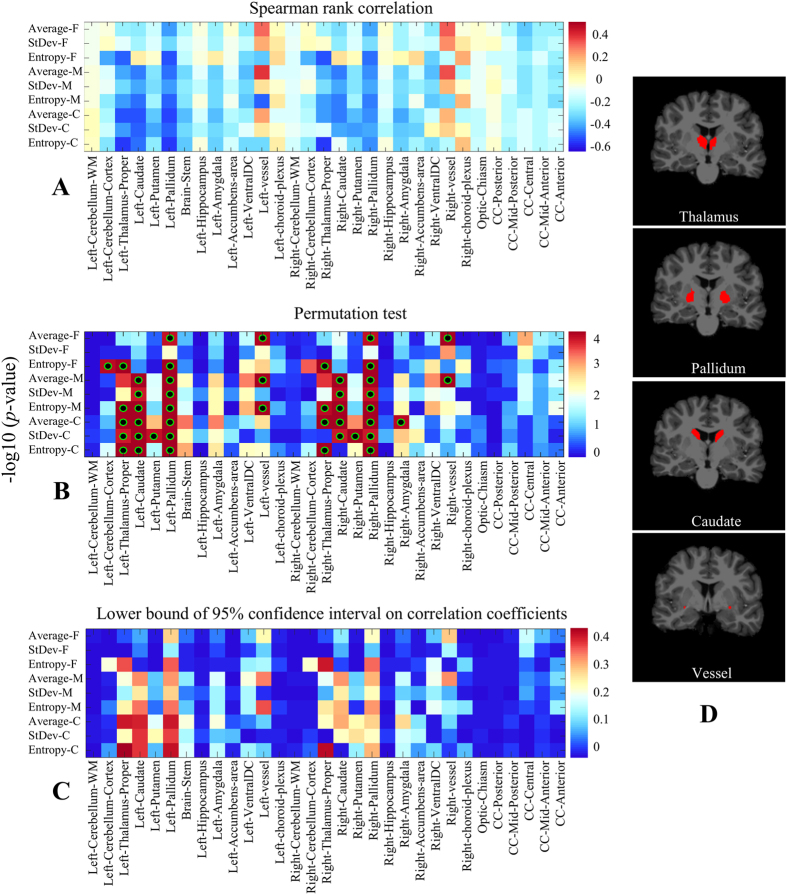
Region-wise correlation between texture features and age in TDC subjects.(A) Heatmap of Spearman rank correlation coefficients. (B) Heatmap of uncorrected p-values (−log10 space), based on 100,000 permutations of age labels. Green-black circles indicate region-scale values with significant p-values following Holm-Bonferroni correction. (C) Lower bound of the 95% confidence interval of absolute correlation coefficients, based on 100 bootstrap samples of 100 TDC subjects. (D) Regions showing significant (moderate or high) correlation between texture and age, with corrected p < 0.05.